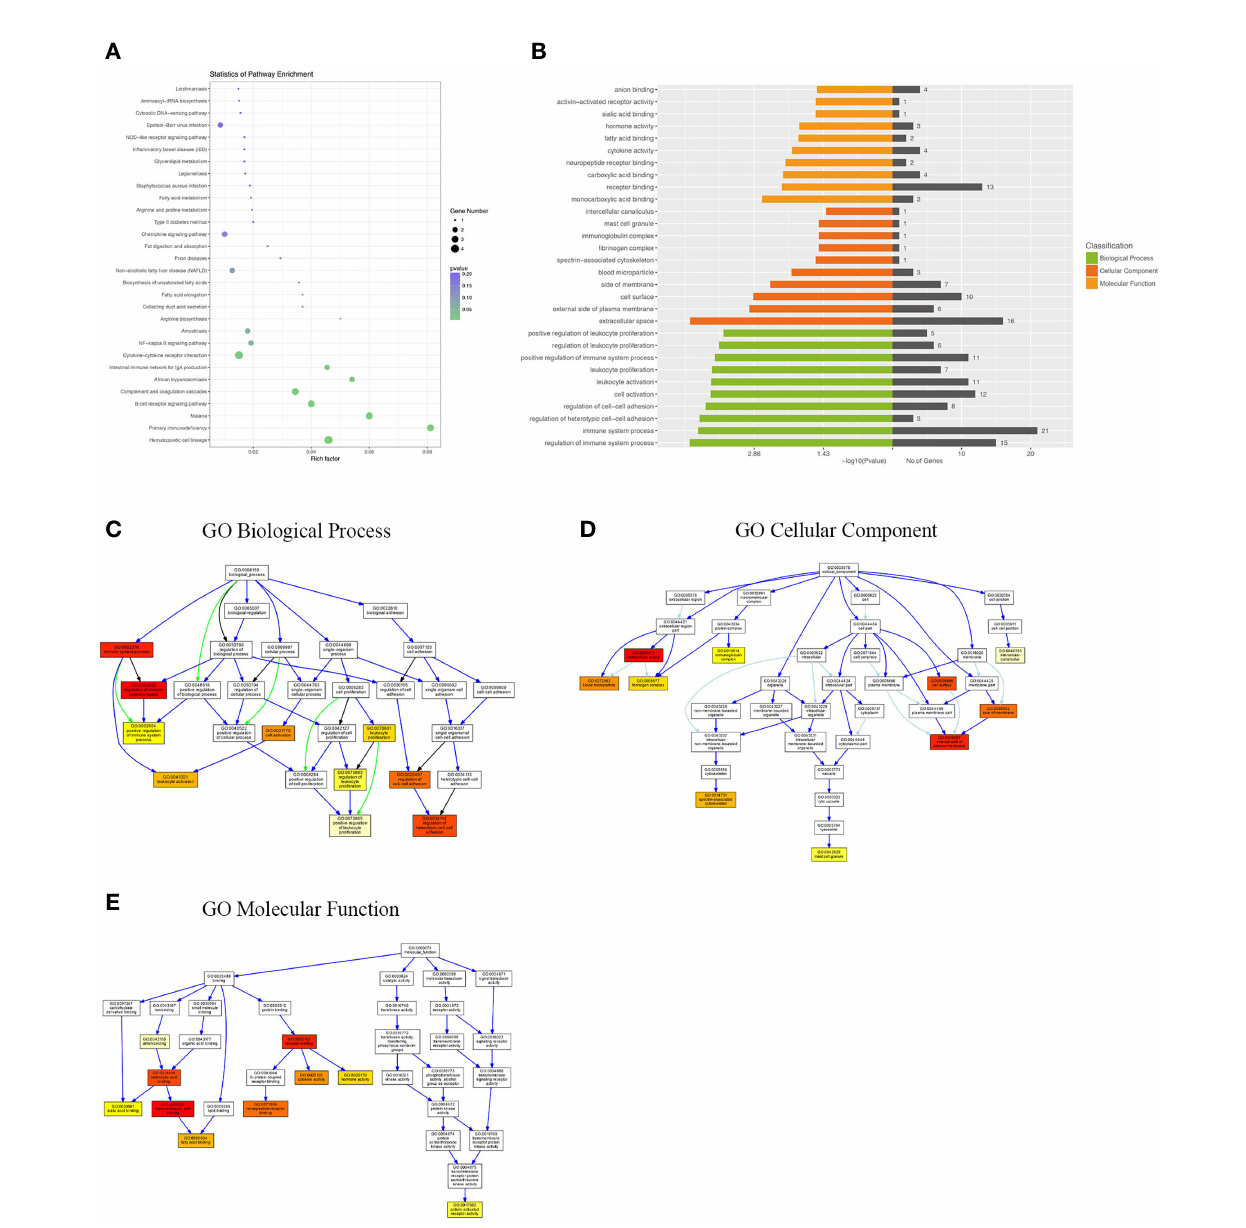
FIGURE 4 | KEGG pathway and GO analysis of DEGs between WT-PCP mice and BAFF-R – / – PCP mice. (A) KEGG pathway analysis of DEGs between the WT- PCP group and the BAFF-R – / – PCP group. (B) GO analysis of DEGs between the WT-PCP group and the BAFF-R – / – PCP group. (C) Changes in the biological processes of DEGs. (D) Changes in the cellular component of DEGs. (E) Changes in the molecular function of